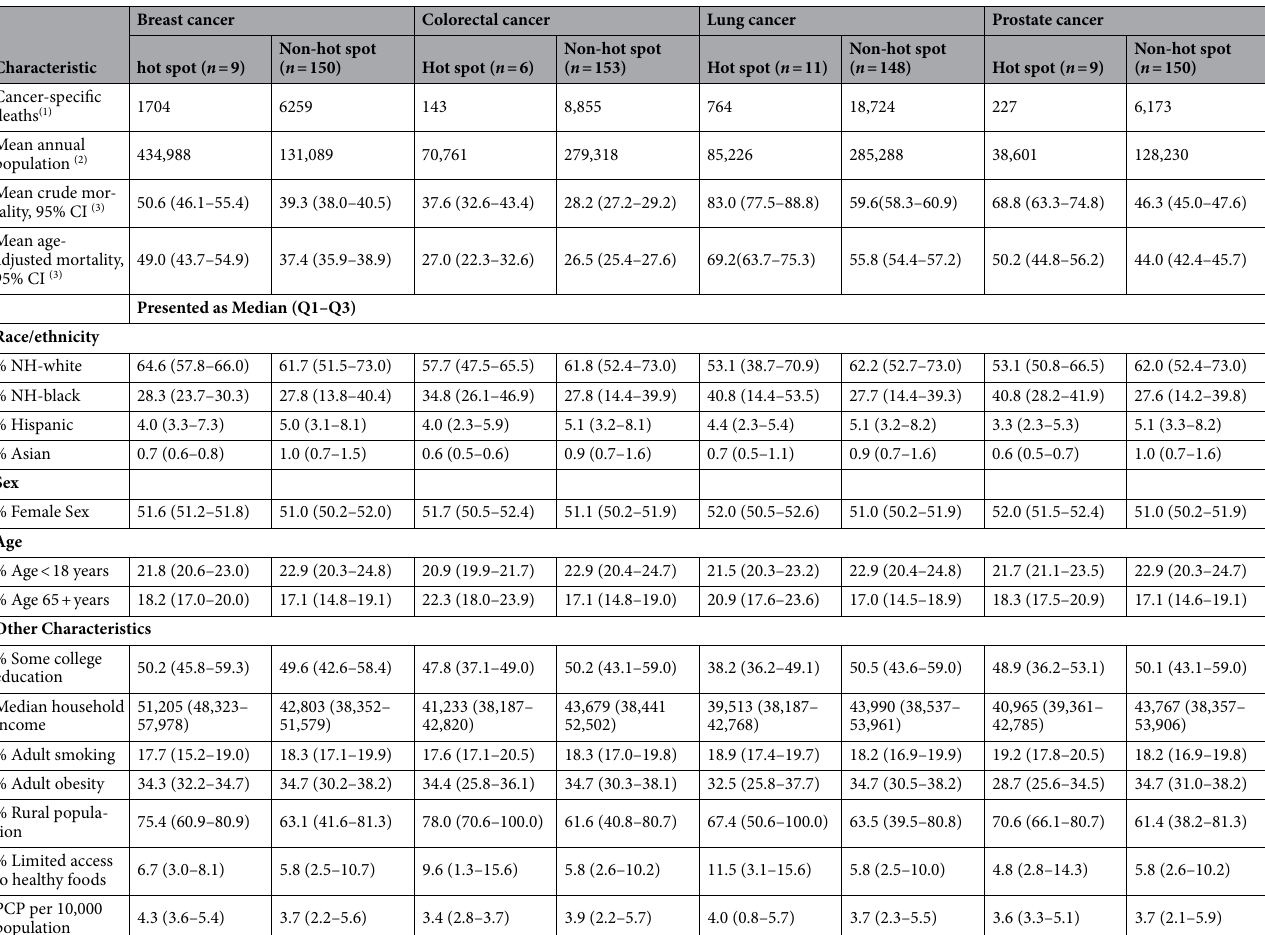
Table 3. Patterns of county-level community health risk factors and behaviors by cancer mortality hot spot classification, stratified by cancer types among NH-black adults in Georgia 1999–2019. (1) Total number of cancer specific deaths from 1999 through 2019. (2) Mean annual population for total period (1999–2019) among counties within hot spot classification. For sex-specific cancers of breast and prostate, these mean population estimates are women and men, respectively. (3) Mortality rates are per 100,000 population. For sex-specific cancers of breast and prostate, they are per 100,000 women and men, respectively. 95% confidence limits presented with